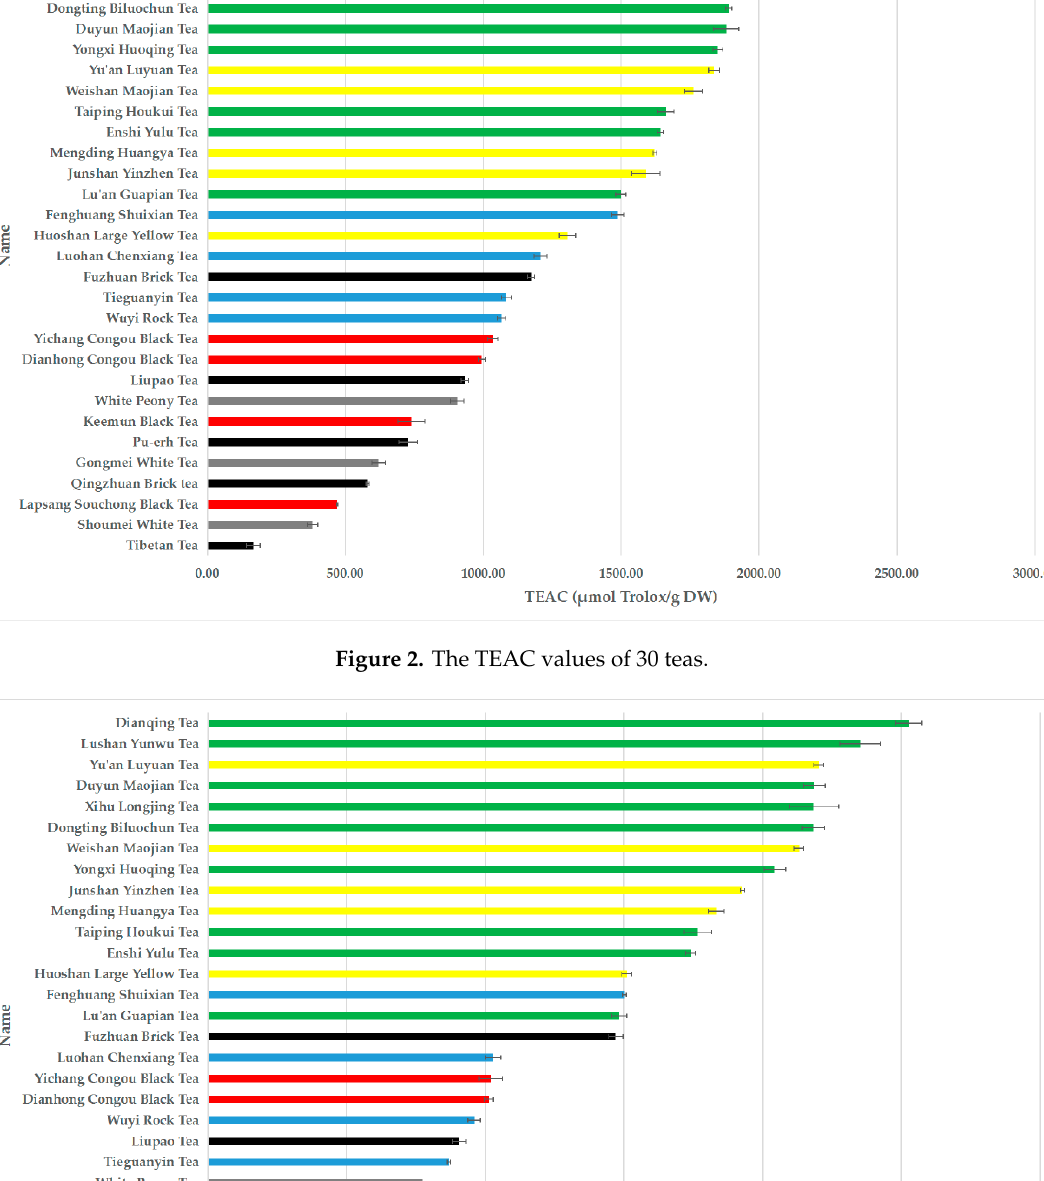
Figure 1. The FRAP values of 30 teas.